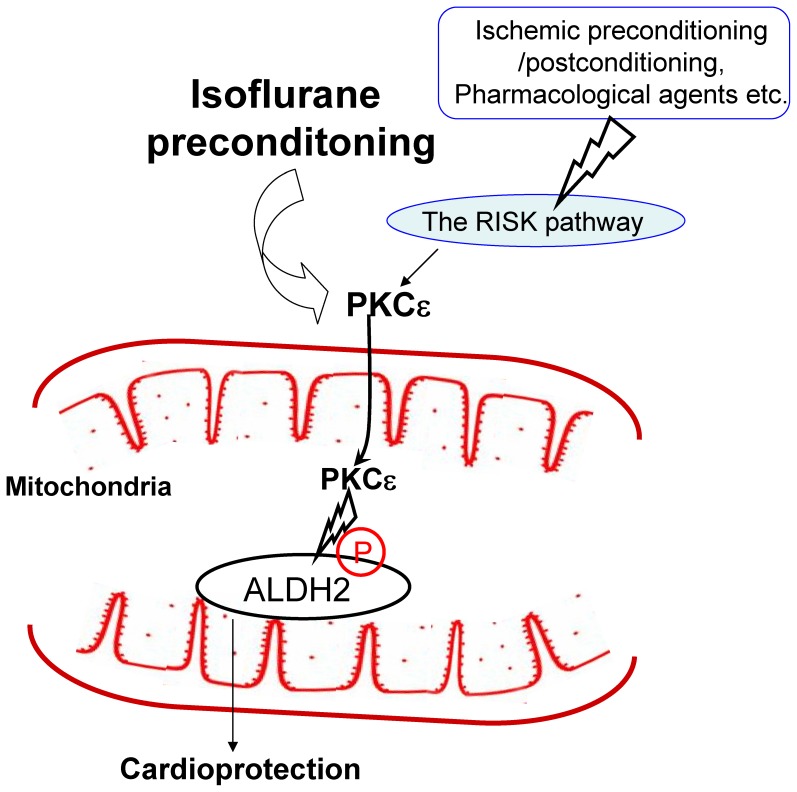
Hypothetical scheme demonstrate that the phosphorylation of ALDH2 through mitochondrial translocation of PKCε plays an important role in the cardioprotection of isoflurane preconditioning in myocardium I/R injury.Ischemic preconditioning/postconditioning and pharmacological agents result in the activation of the RISK pathway, which lead to the phosphorylation and mitochondrial translocation of PKCε.